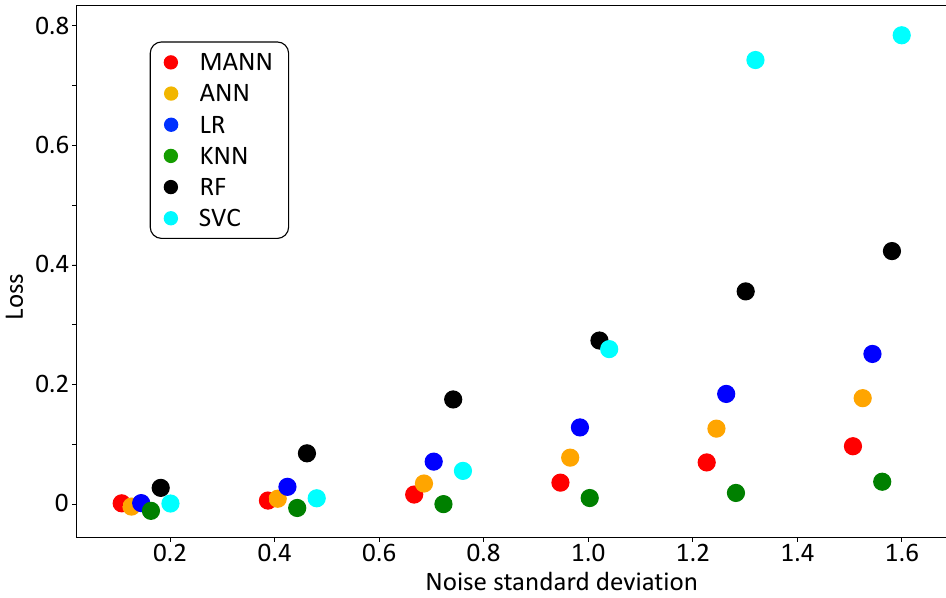
Figure 5. Noise robustness comparison. It shows how, as noise grows, MANN has a good noise